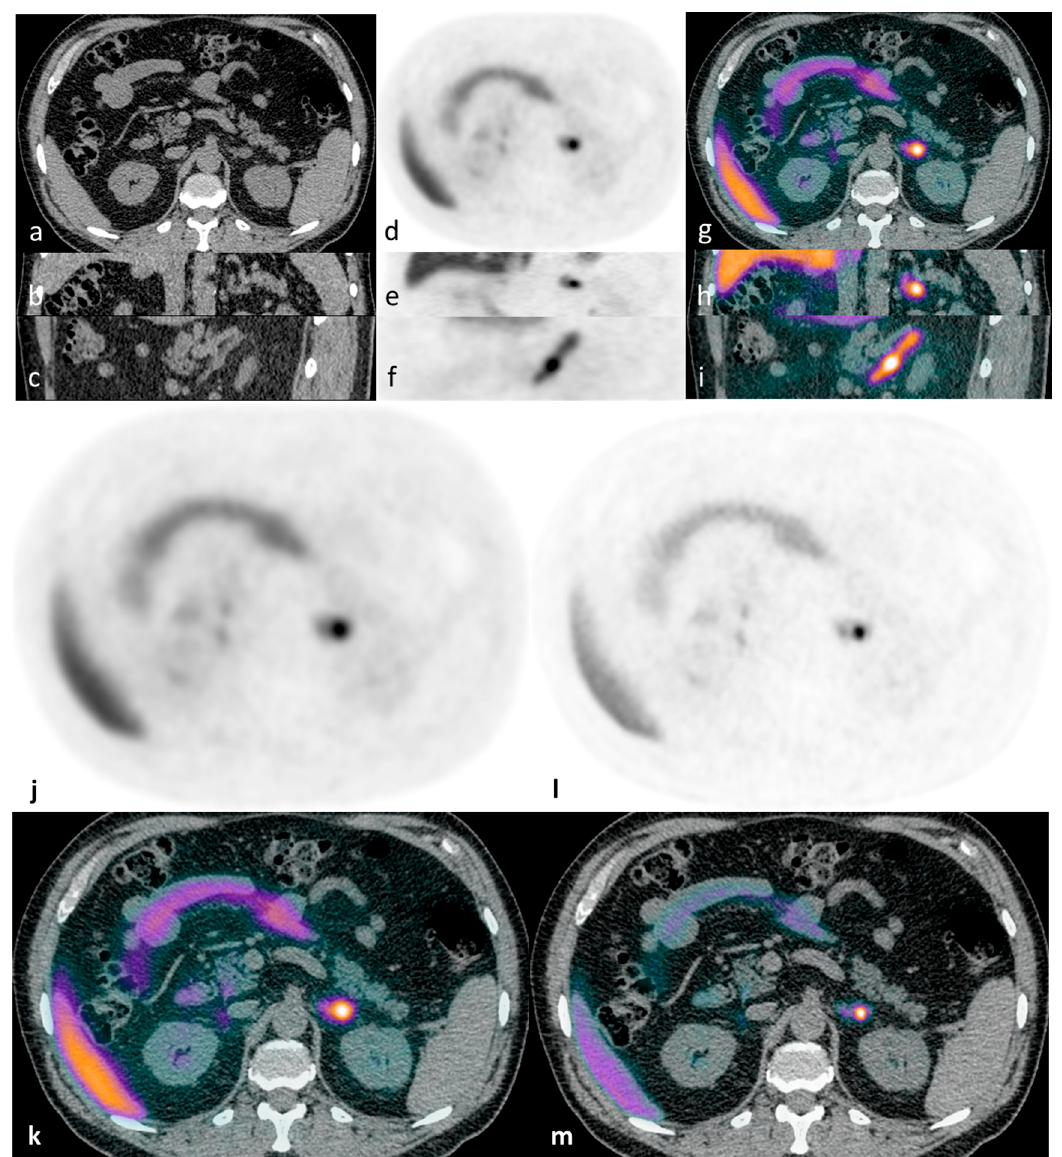
Figure 1. Illustrative case 1: A 65-year-old man with a ten-year history of hypertension and hypokalaemia, requiring multiple agents for blood pressure control (including eplerenone) and oral potassium supplementation, was diagnosed with primary aldosteronism. CT demonstrated a lipid-poor 12 mm left adrenal nodule - displayed in axial, coronal and sagittal planes ( a – c ). 11 C-metomidate PET-CT [( d – f ) (PET) and ( g – i ) (PET-CT)] confirmed increased tracer uptake in the left adrenal nodule. The patient underwent laparoscopic left adrenalectomy, with subsequent histology confirming a classical Conn’s adenoma. Post-operatively, he had complete resolution of his hyperaldosteronism with excellent blood pressure control on progressive down-titrating medications (currently two agents with further weaning planned), and with no requirement for supplemental potassium at four-month follow-up. For comparison, axial PET/PET-CT images are shown as reconstructed via “time-of-flight” (TOF) iterative algorithms: without ( j , k ) and with resolution modeling (SharpIR) ( l , m ).